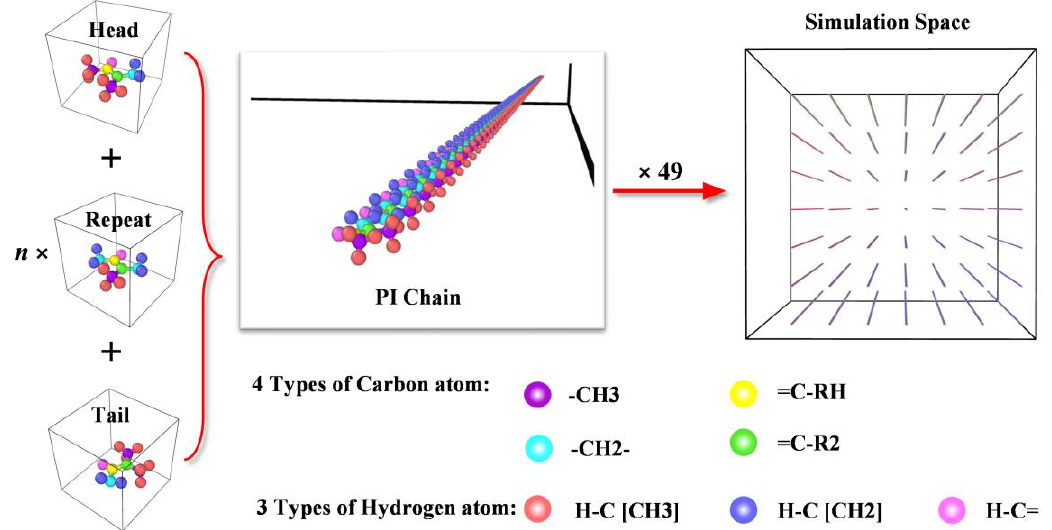
Figure 1. Model process of PI molecular model.